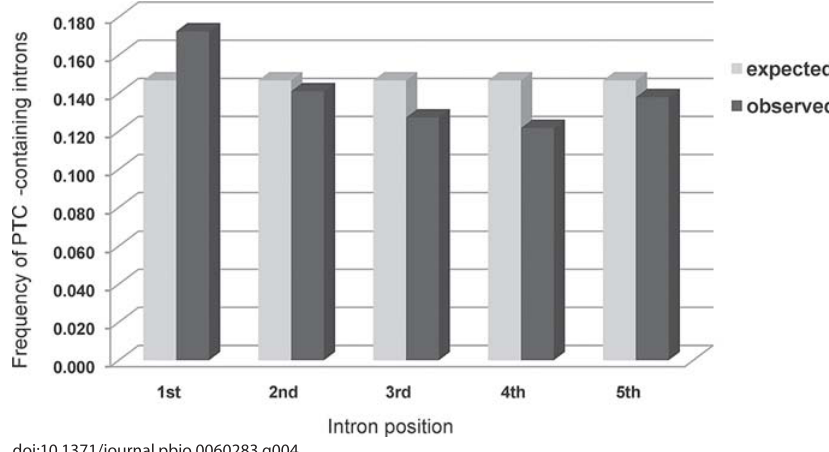
Figure 4. Frequency of PTC-Containing Introns in P. tetraurelia This analysis has been performed using 15,286 EST-confirmed introns [112] and does not include single-intron